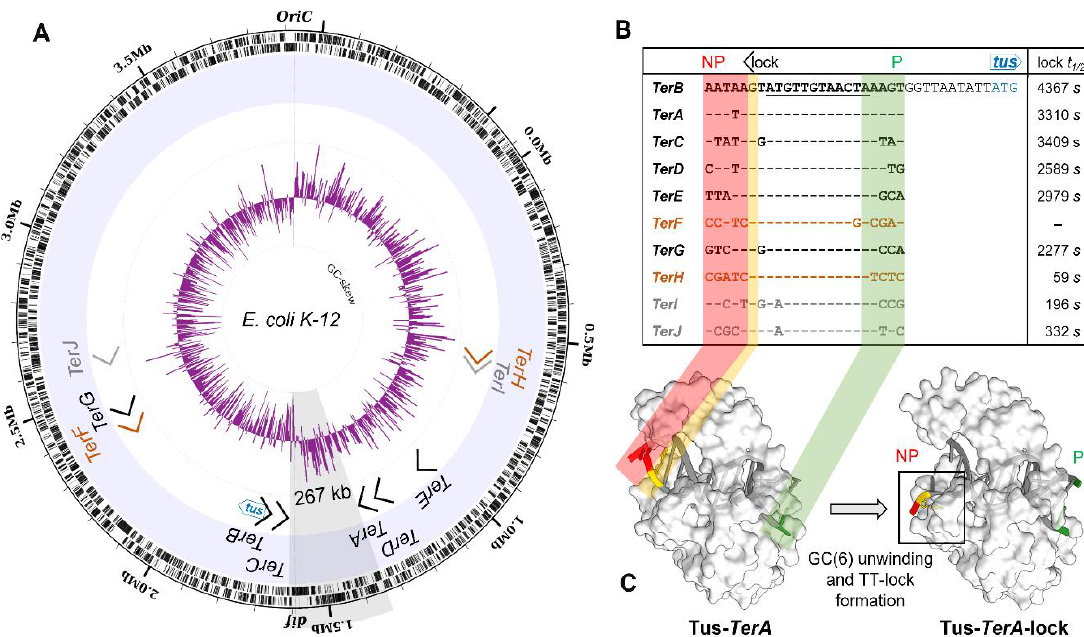
Figure 1. Chromosomal distribution and sequences of Ter sites in E. coli . ( A ) Circular representation of E. coli K12 MG1655. Illustrated from the outside to the centre of the circle: labelled forward and reverse genes; location of the ten primary Ter -sites ( TerA – J ) and their strand orientation; the currently accepted replication termination fork trap involving high-affinity (black), moderate-affinity (grey) and non-lock forming Ter sites (orange); GC-skew (purple) over a 5000 bp window showing a switch in polarity at the replication origin ( oriC ) and close to TerC and the dif site. ( B ) Ter site sequences with the G(6) base complementary to C(6) highlighted in yellow and the strictly conserved 12 bp core sequence (underlined). TerB is located 11 bp upstream of the start codon (ATG) of the tus gene. Half-lifes ( t 1 / 2 ) of Tus – Ter – lock complexes at 250 mM KCl were described previously [5]. ( C ) DNA replication fork arrest at a Ter site. The unwinding action of DnaB helicase breaks the GC(6) base pair at the non-permissive (NP: red) end of a Tus-bound Ter . The C(6) docks into the cytosine-specific binding pocket (boxed) forming an extremely stable Tus – Ter – lock complex. Permissive (P) end of Ter : green.